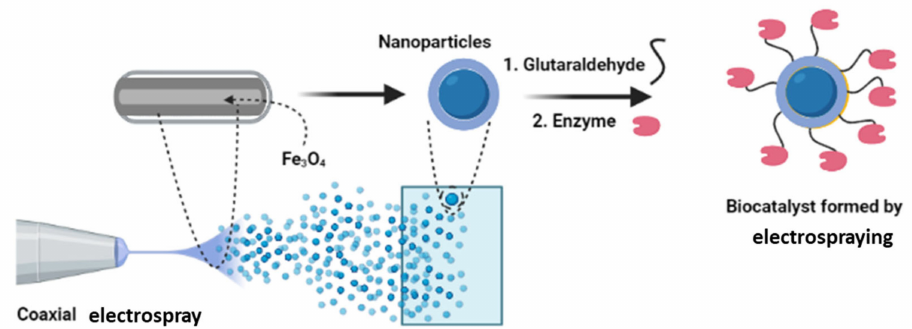
Figure 6. Electrospraying enzyme immobilization method. First, iron nanoparticles stop by electro- spraying, then they are activated with glutaraldehyde, and then the enzymes bind to the electro- spraying nanoparticles by physical/covalent adsorption or encapsulation depending on the size of the